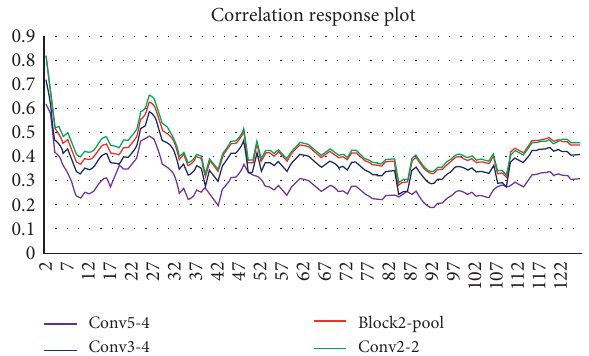
Figure 4: Frame-by-frame maximum response values of different convolutional layers on the Dog sequence. The response value of the last layer is the smallest, and the lower convolution layer has a higher spatial resolution achieving the higher the response value.